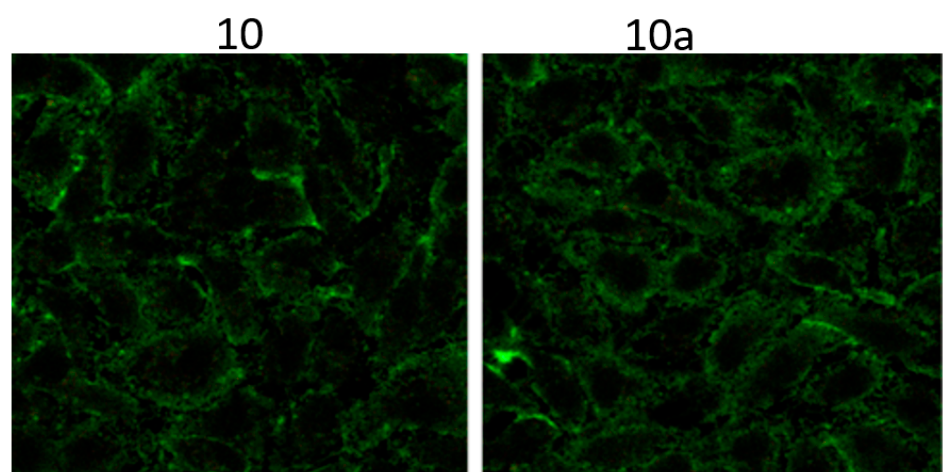
Figure 13. Comparative change in fluorescence before ( left ) and after ( right ) the addition of cysteine- enriched medium. The image was obtained at an excitation wavelength of 488 nm.